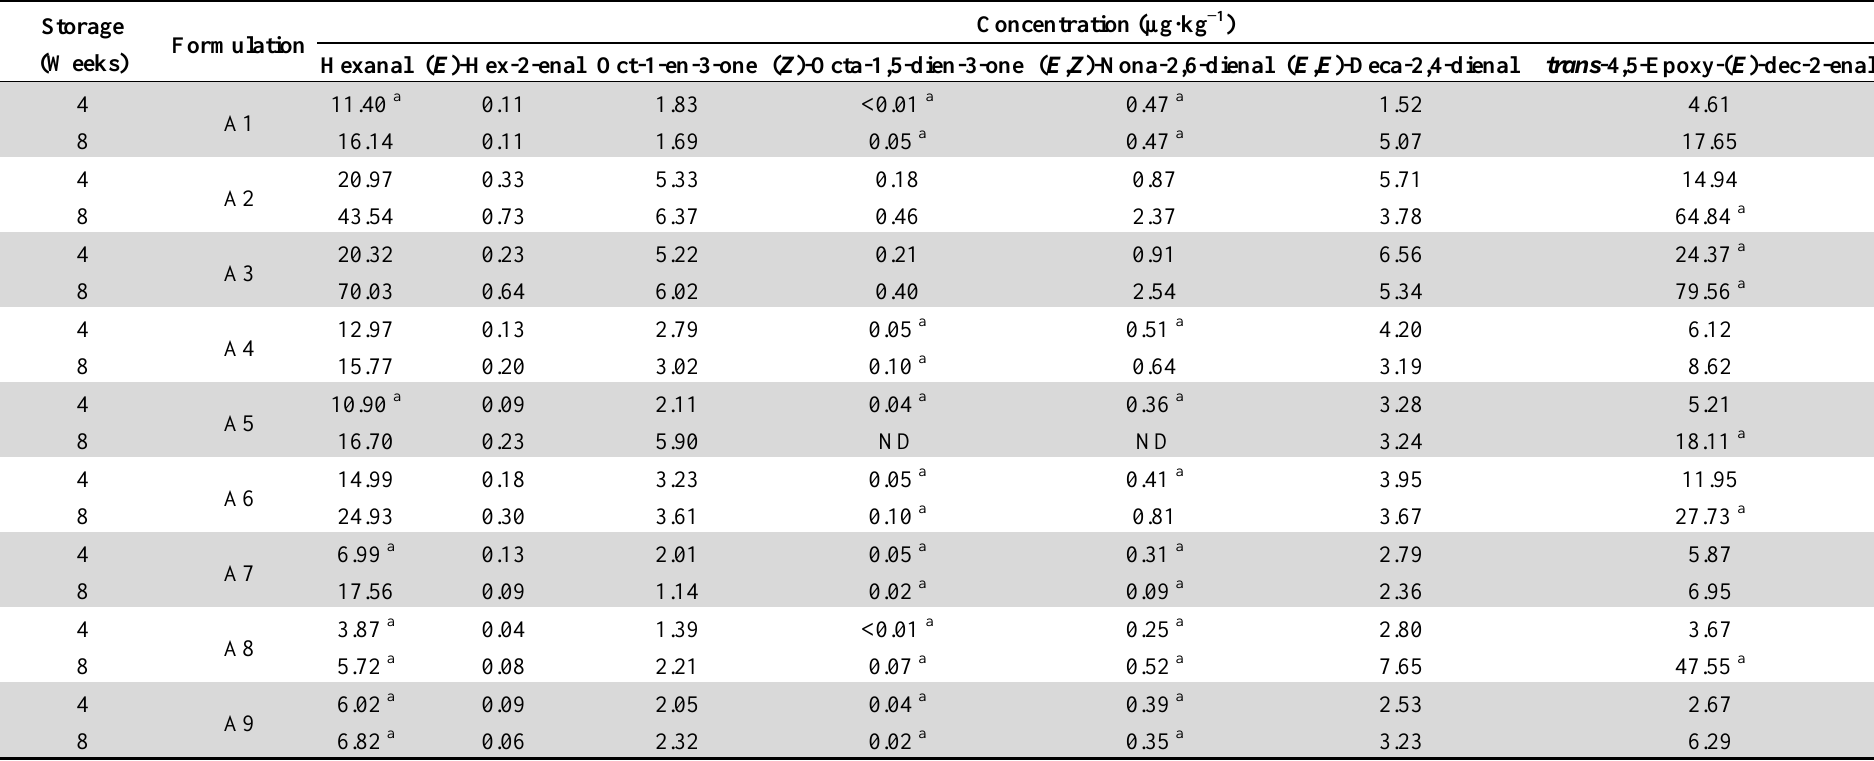
Table 5. Quantification of selected odorants in infant formulations after four and eight weeks of storage with antioxidants.